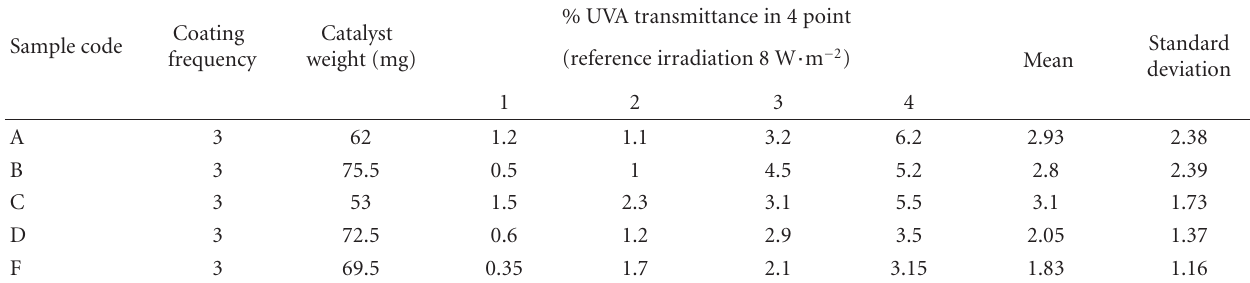
Table 3: Coating frequency, UVA transmittance, and catalyst coating weight results for the spraying technique. Sample code